Question: What visual encoding does this figure use to show its data?
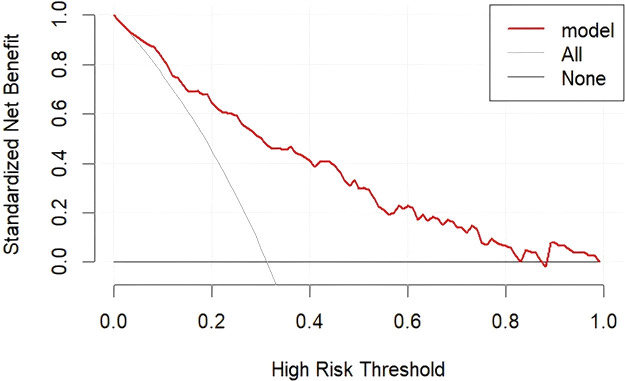
Answer: line